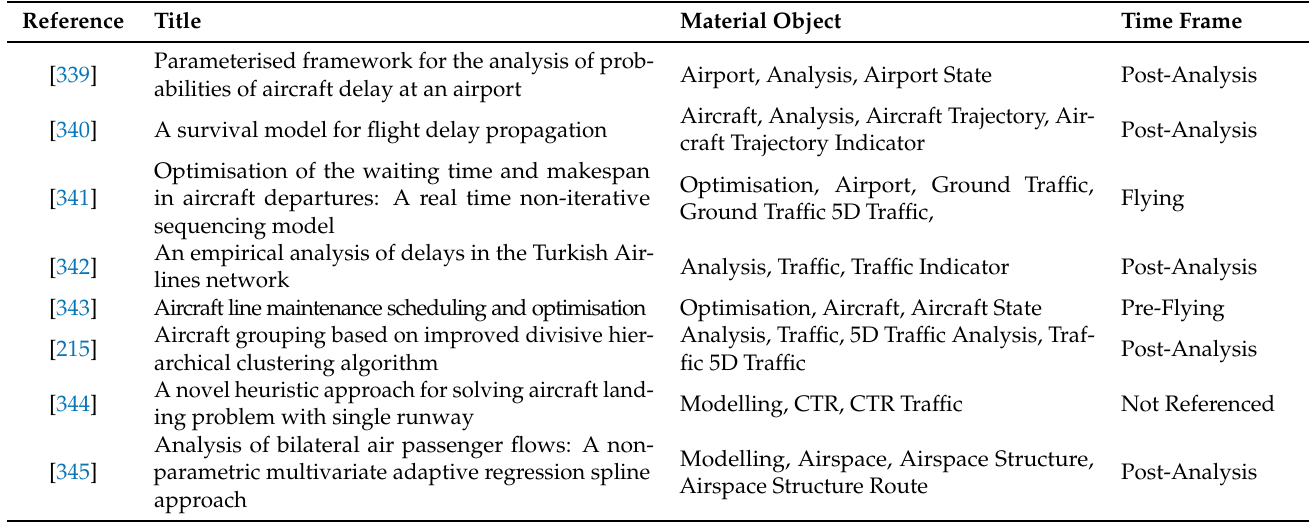
Table A1. Principal extracted features from